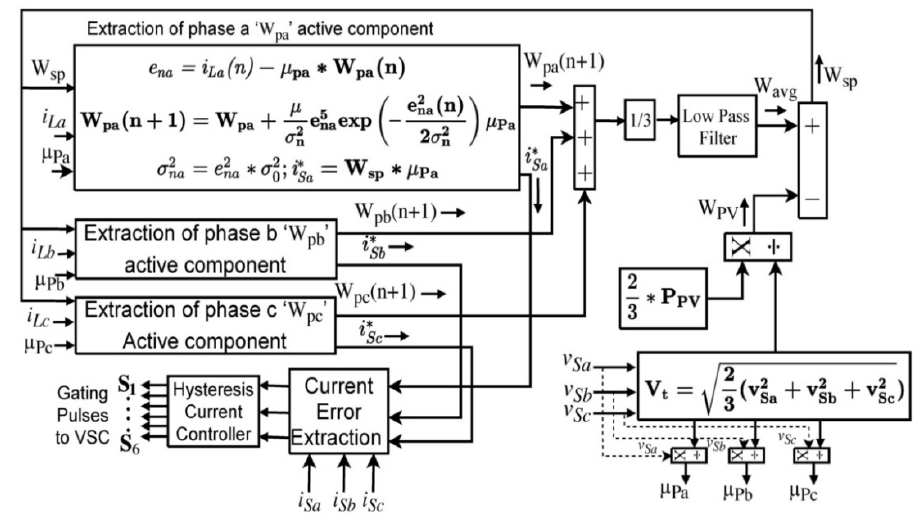
Figure 7. AKWSOMCC based VSC control.